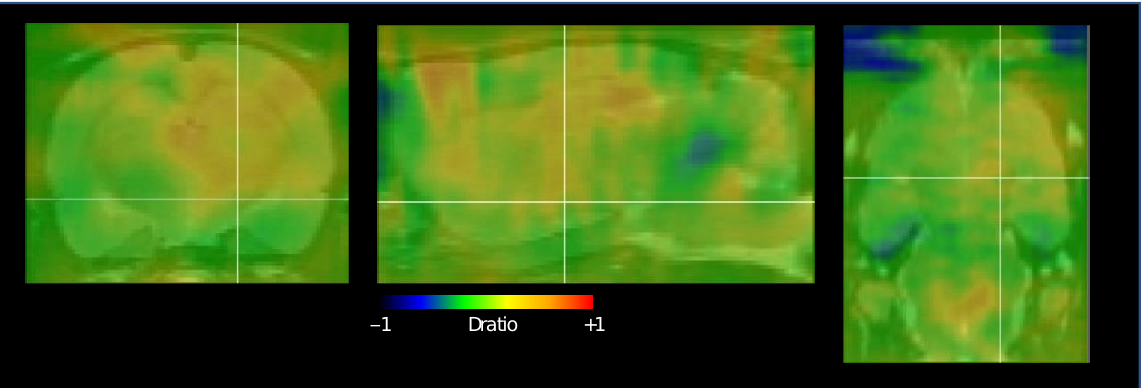
Figure 3. Significant increase in [ 18 F]FDG uptake in different brain areas during STN-HFS 3 days after intervention in a coronal (left panel), sagittal (middle panel) and horizontal view (right panel). The panels represent the difference between glucose metabolism with and without STN-HFS. There is an increase of glucose metabolism in the corticosubthalamic and pallidothalamic circuit as well as in the brainstem. PET images are superimposed on an MRI template in gray (MRI template from PMOD software). ∆ ratio, ratio between stimulated and non-stimulated animals, after normalization to the cerebellum.